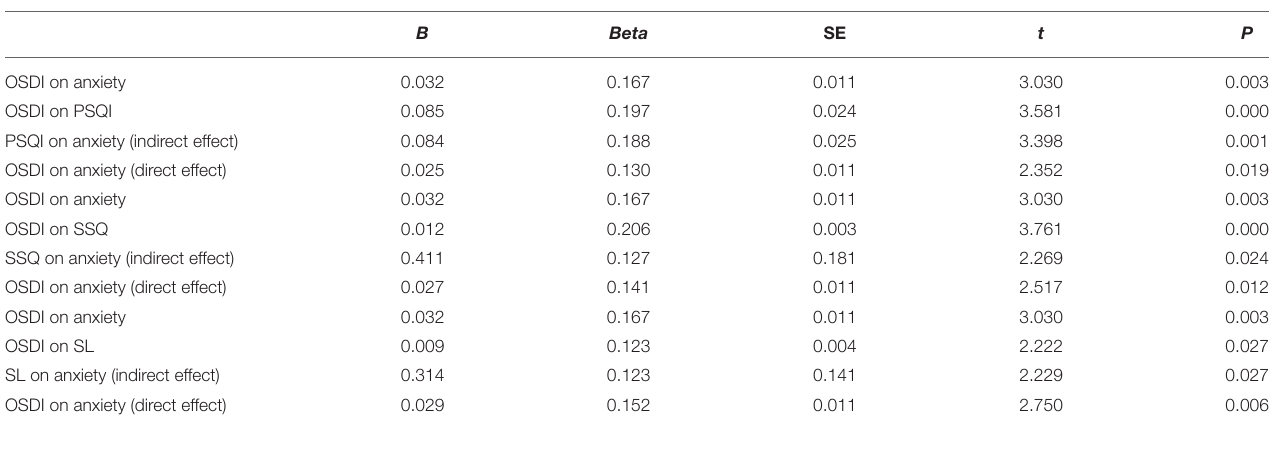
TABLE 4 | Mediation analysis of PSQI,SSQ,SL on the relationship between the OSDI and anxiety.